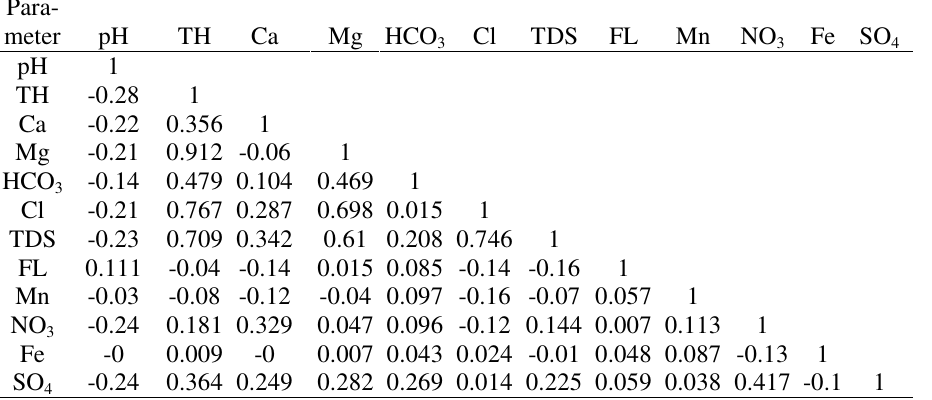
Table 5 . Correlation coefficient matrix of water quality